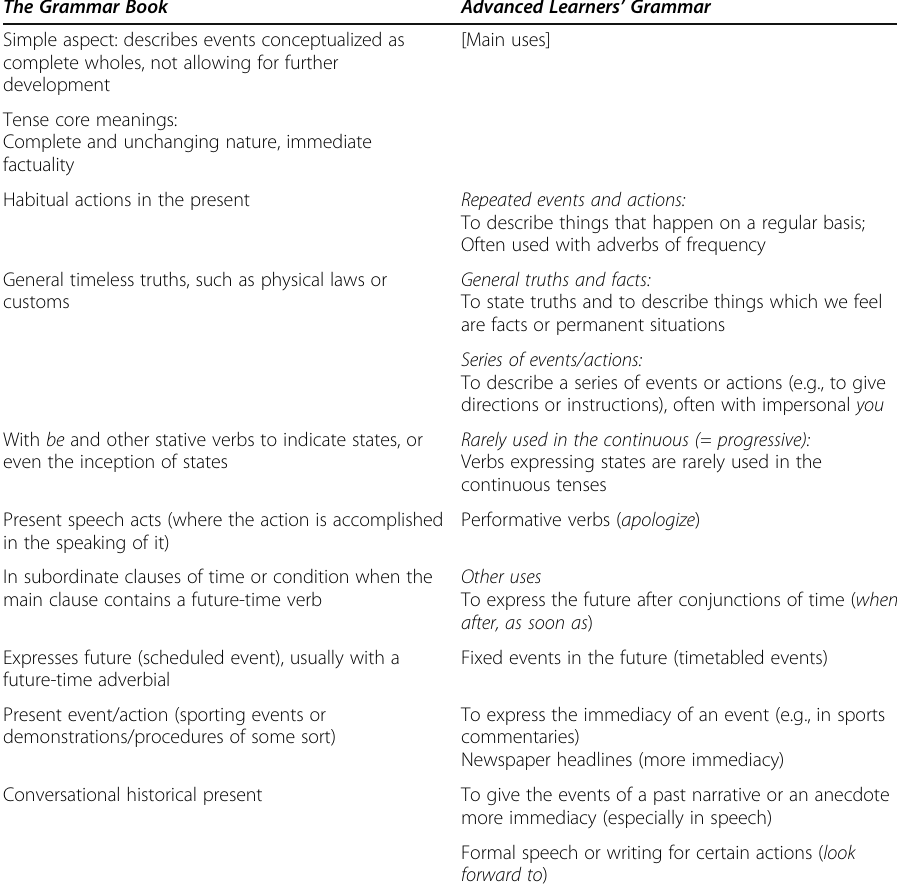
Table. 2 Simple present tense: rules of use (from The Grammar Book and Advanced Learners ’ Grammar ) The Grammar